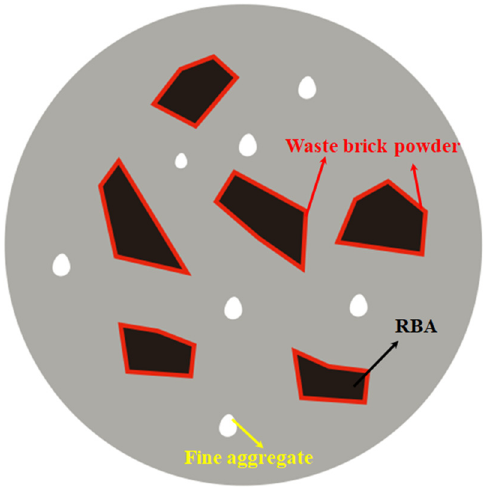
Figure 5: Interface model of RBC.